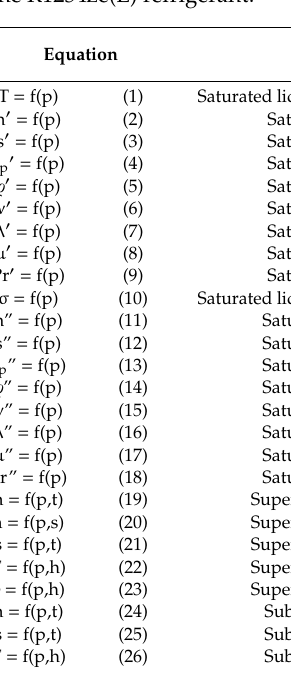
Table 11. Correlation and determination coe ffi cients of the equations used to calculate the properties of the R1234ze(E) refrigerant.